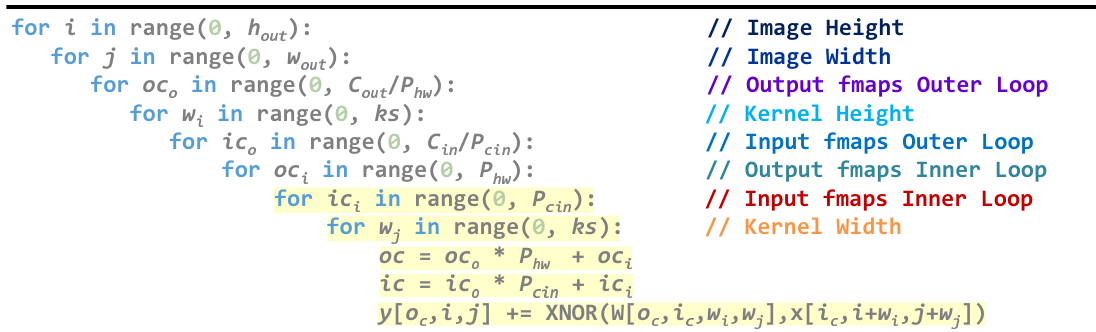
Figure 3. BNN layers’ loop for the first parallelism scheme; the loops highlighted in light yellow are computed in one clock